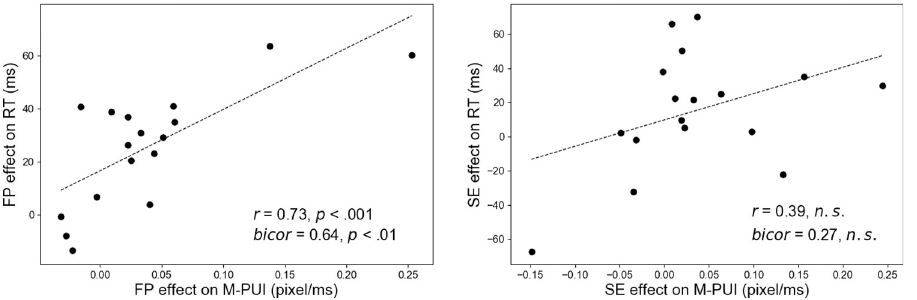
Fig 6. Scatterplots of individual magnitudes of FP/SE effects on RT and M-PUI.